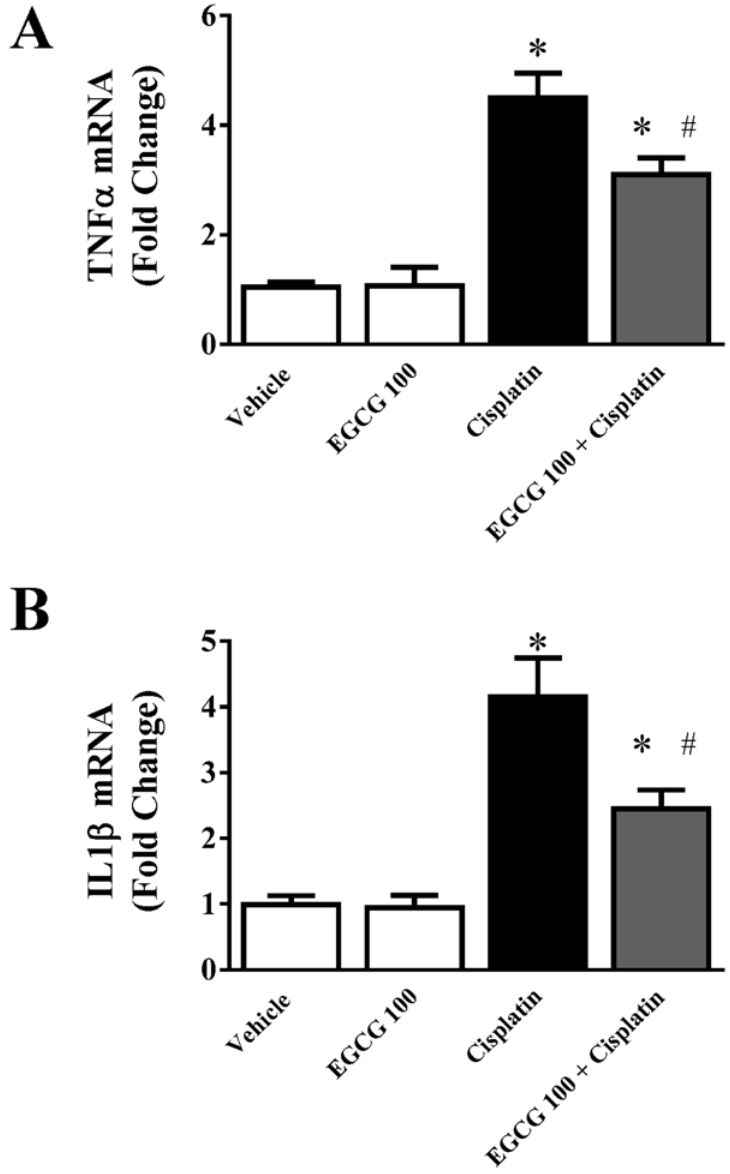
Fig 6. Effect of EGCG on cisplatin-induced pro-inflammatory cytokines in mice. Real-time PCR based analyses of pro-inflammatory cytokines TNF α and IL1 β indicated profound increase in cisplatin treated mice. EGCG treatment attenuated cisplatin induced TNF α and IL1 β production. Results are mean ± S.E.M. n = 4/ group. * p < 0.05 versus vehicle; and # p < 0.05 versus